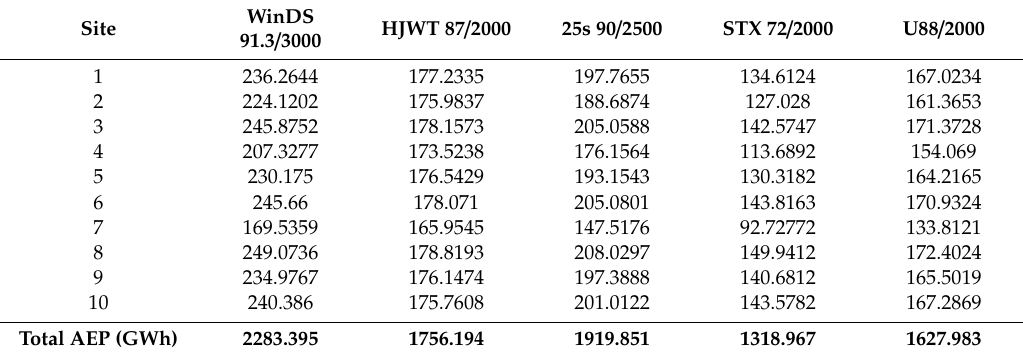
Table 6. Annual electricity production at each site.